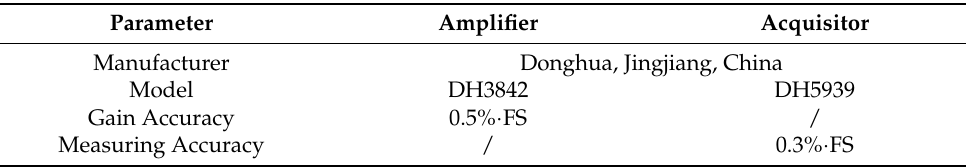
Table 1. Performance parameters of the instruments.